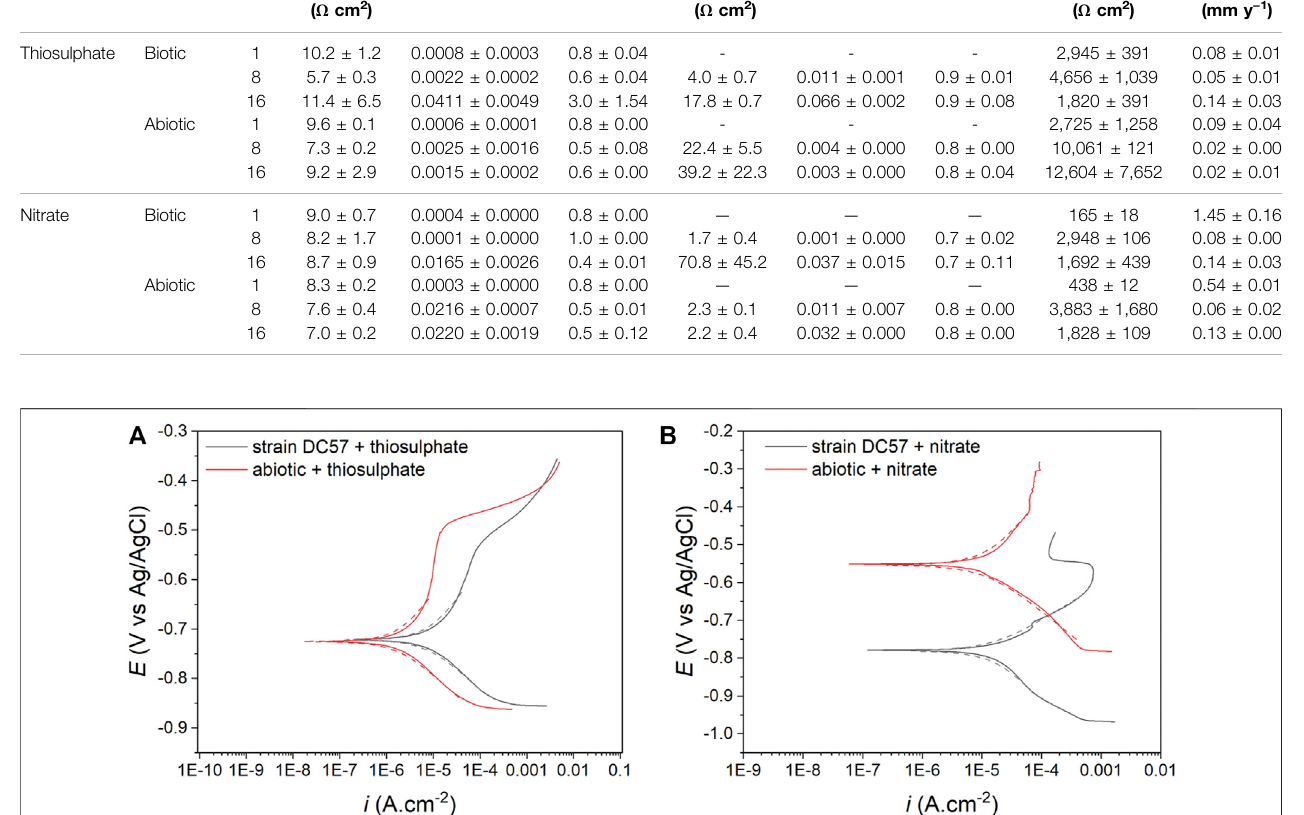
TABLE 1 | Electrochemical parameters obtained from fi tting the EIS spectra in Figure 3 and calculated corrosion rate. Condition